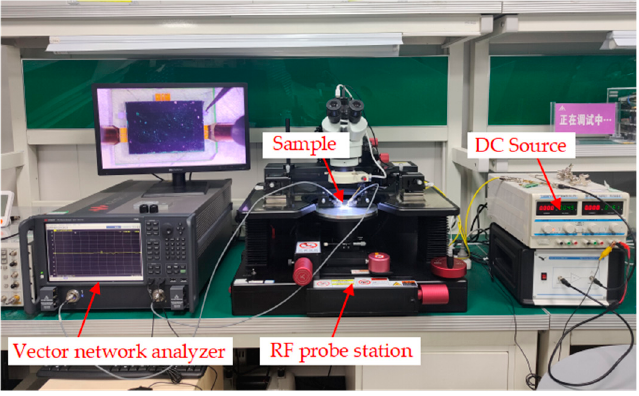
Figure 6. Microwave performance test of the MEMS electronic calibration chip.